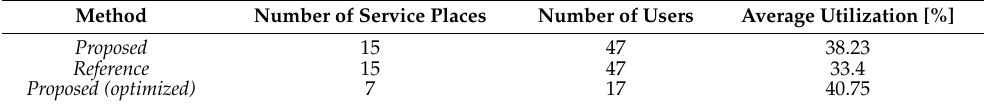
Table 5. A comparison of the average utilization of the service system for our method and the au ‐ thor’s method.